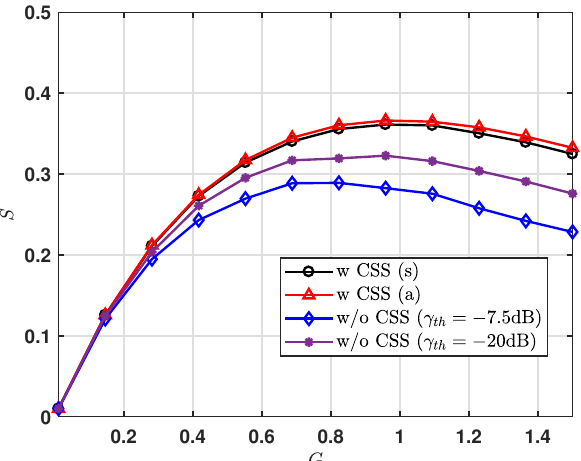
Figure 7. Normalized total throughput vs.